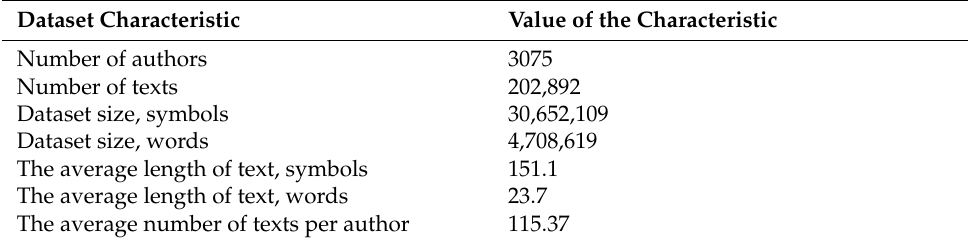
Table 2. Description of the short texts’